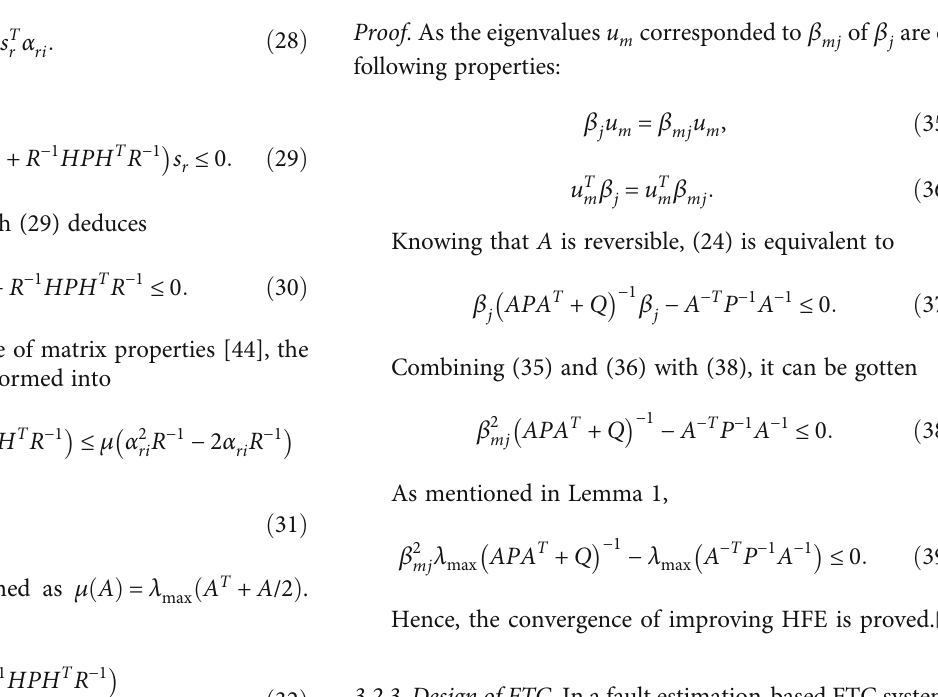
Figure 7: Output switching logic of the Kalman fi lter in the improved hybrid FTC